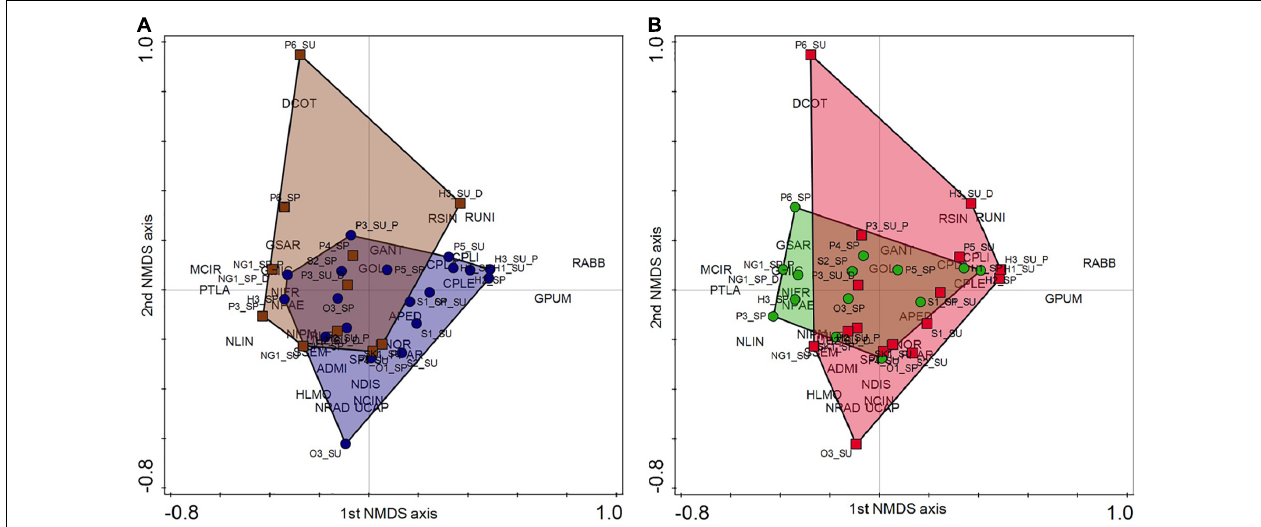
FIGURE 2 | Results of the species-based Non-metric Multi-dimensional Scaling (NMDS) analysis of benthic diatom assemblages. Four letter codes indicate the 208 taxa identified in the samples (see list and codes in Supplementary Table 5 ). (A) Dry phase is marked with brown squares (their covered area is brown). Aquatic phase is marked with blue circles (their covered area is blue). (B) Spring period is marked with green circles (their covered area is green). Summer period is marked with red squares (their covered area is red).